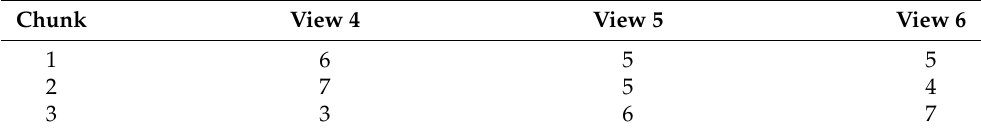
Table 13. Initial number of clusters in three chunks for each view—Tap-water System Chunk View 4 View